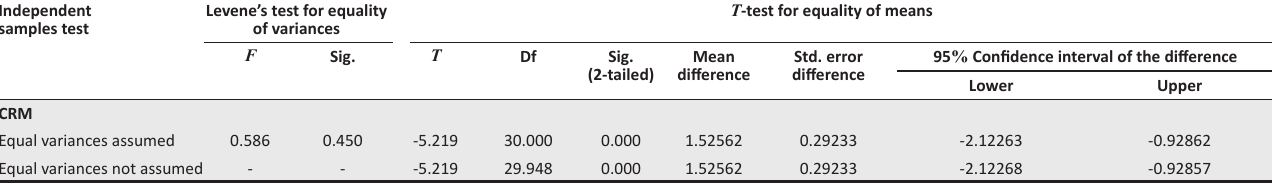
T -test for equality of means